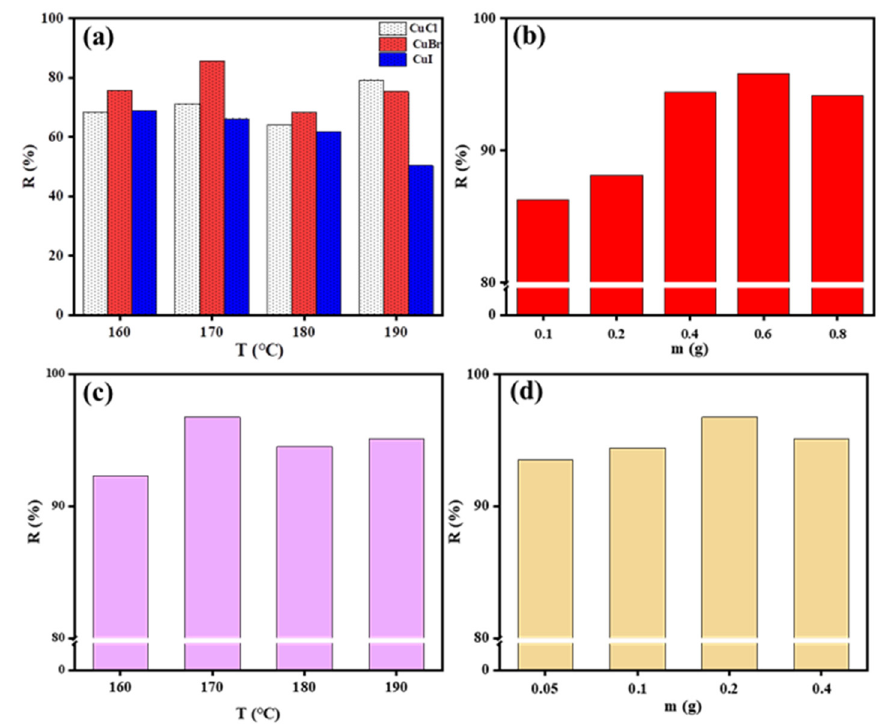
Figure 4. Effect of different synthesis conditions for the adsorption of Cu 2 MoS 4 (( a ) the copper source and temperature, ( b ) the mass of CuBr) and FeMoS 4 (( c ) the temperature and ( d ) the mass of FeCl 2 · 4H 2 O) to CTC. (C sorbent = 0.4 g/L, C 0 = 100 mg/L, T = 298 K).